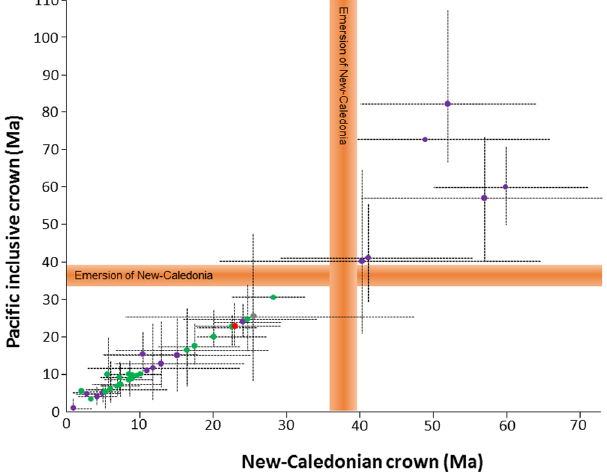
Figure 3. Estimated crown age of the New Caledonian and Pacific island clades from the 40 selected studies. Dotted lines indicate confidence intervals when available. Purple: arthropods, green: plants, red: vertebrates, grey: molluscs.